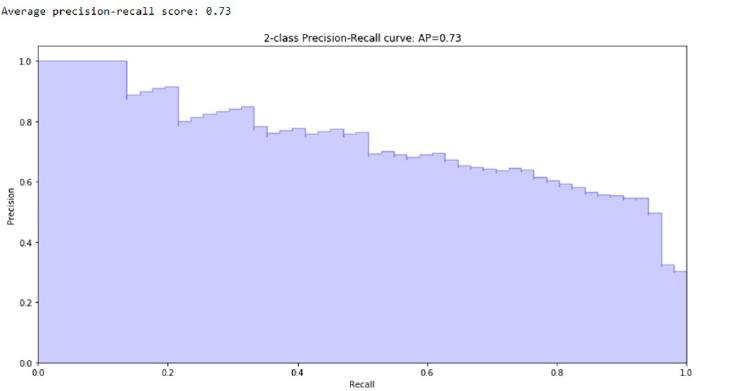
Fig 6. Precision-Recall curve of the RF